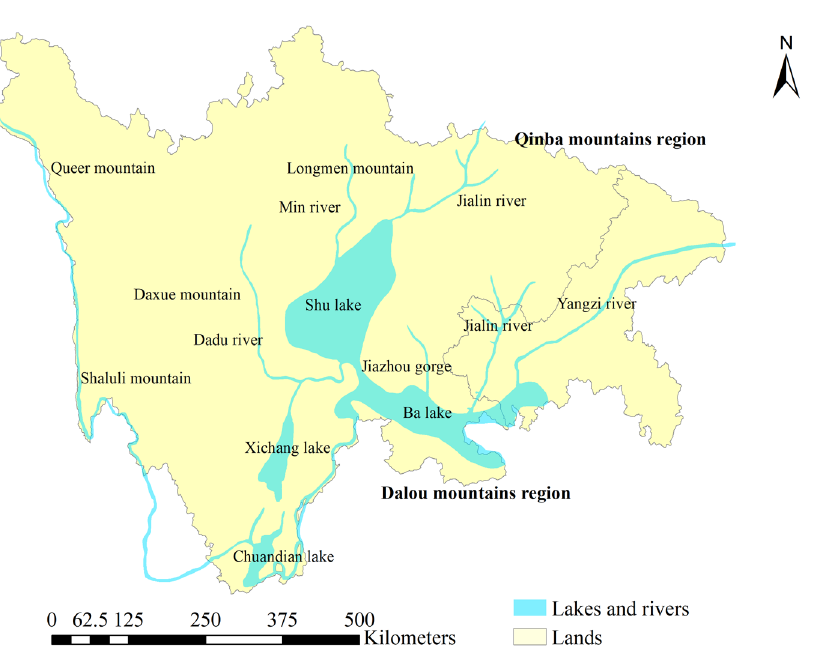
Figure 3. Schematic diagram of the Cretaceous palaeoenvironment of the Sichuan